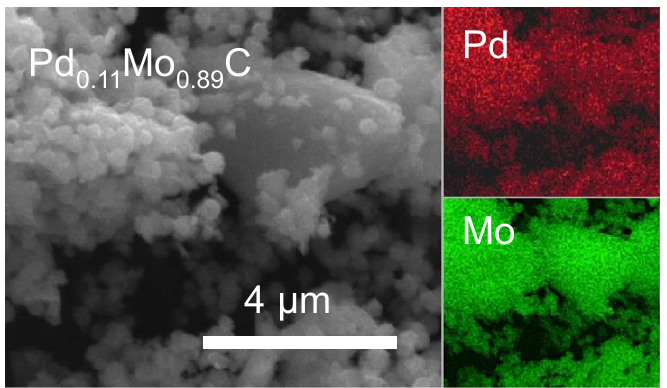
Figure 5. SEM of Pd-Mo cubic ternary carbide annealed to 1200 °C with 11% Pd. The elemental mapping of the sample shows uniform Pd (red) and Mo (green).